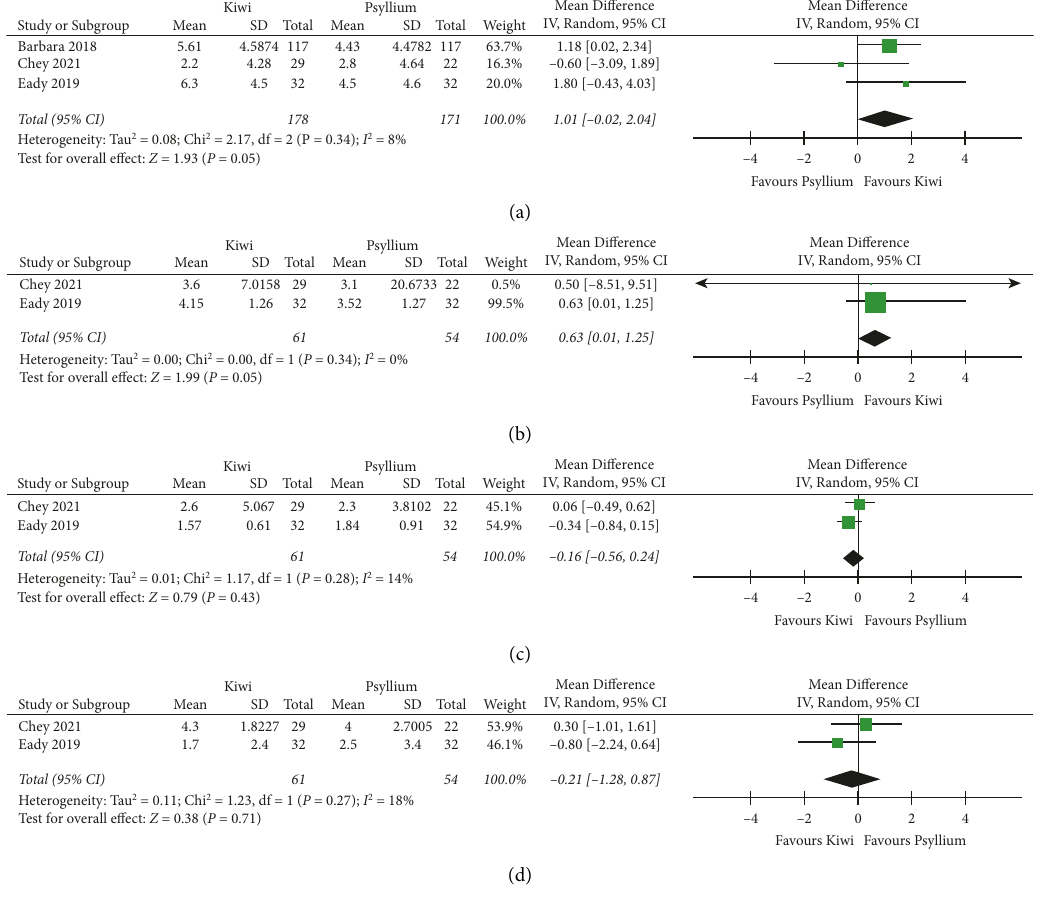
Figure 4: Forest plots for kiwifruits product vs. psyllium. (a) Weekly frequency of spontaneous bowel movements. (b) Bristol stool chart score. (c) Abdominal pain (lower number indicates improved abdominal pain). (d) Straining (lower score indicates less